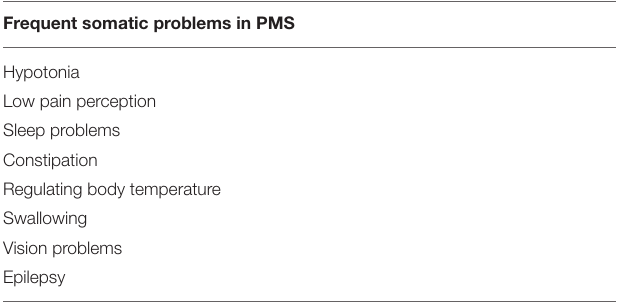
TABLE 4 | Previously published frequent somatic problems in PMS. Frequent somatic problems in